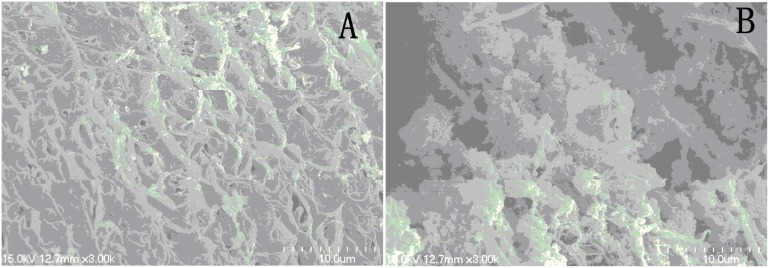
Scanning electron microscopy (SEM, ×3000) observation on male adult Schistosoma japonicum exposed to the medium containing DW-3-15 (25 µM, 17.4 g/mL) for 72 h.A: The mid-region of body wall shows fusion of ridges after incubation with DW-3-15; B: The inner wall of shows gynecophoral canal clefts after incubation with DW-3-15 for 72 h.